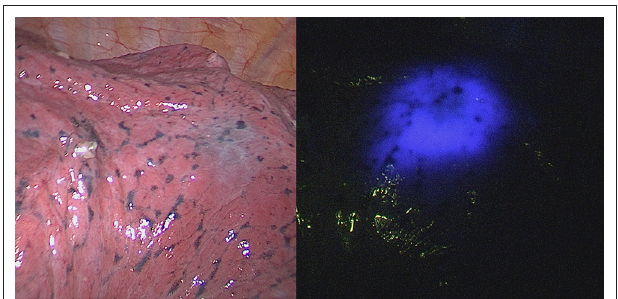
FIGURE 2 | Thoracoscopic view of ENB methylene blue dye marked lesion that is difficult to identify (left side) , clearly visible fluorescence from ICG dye with near-infrared light for the same marked lesion (right side)